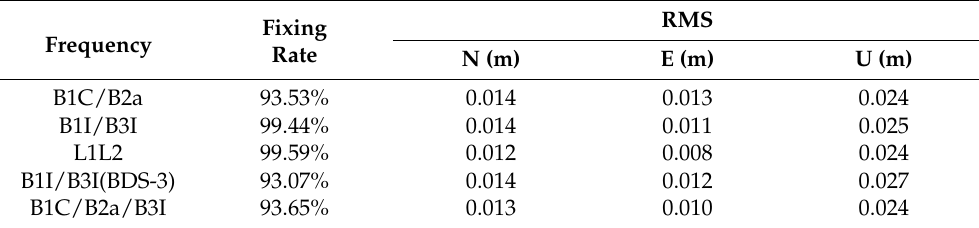
Table 7. TGDA-TGCU (96 km) average of medium baseline RTK RMS and ambiguity fixing rate. Fixing Frequency